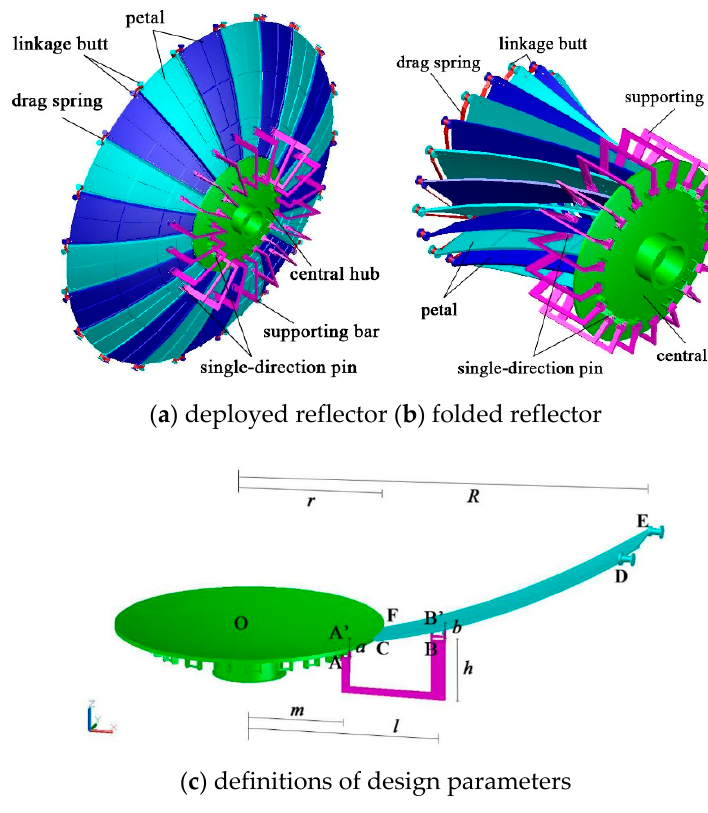
Figure 1. Schematic diagram of Petal-type Deployable Solid-surface Reflector (PDSR) model.